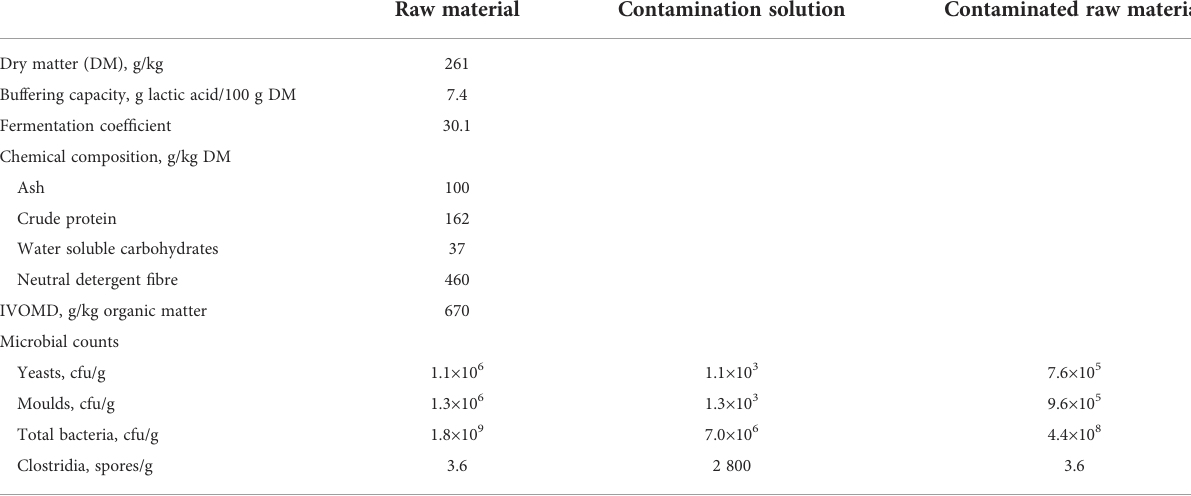
TABLE 1 Composition and microbial counts of red clover dominated raw material and the contamination